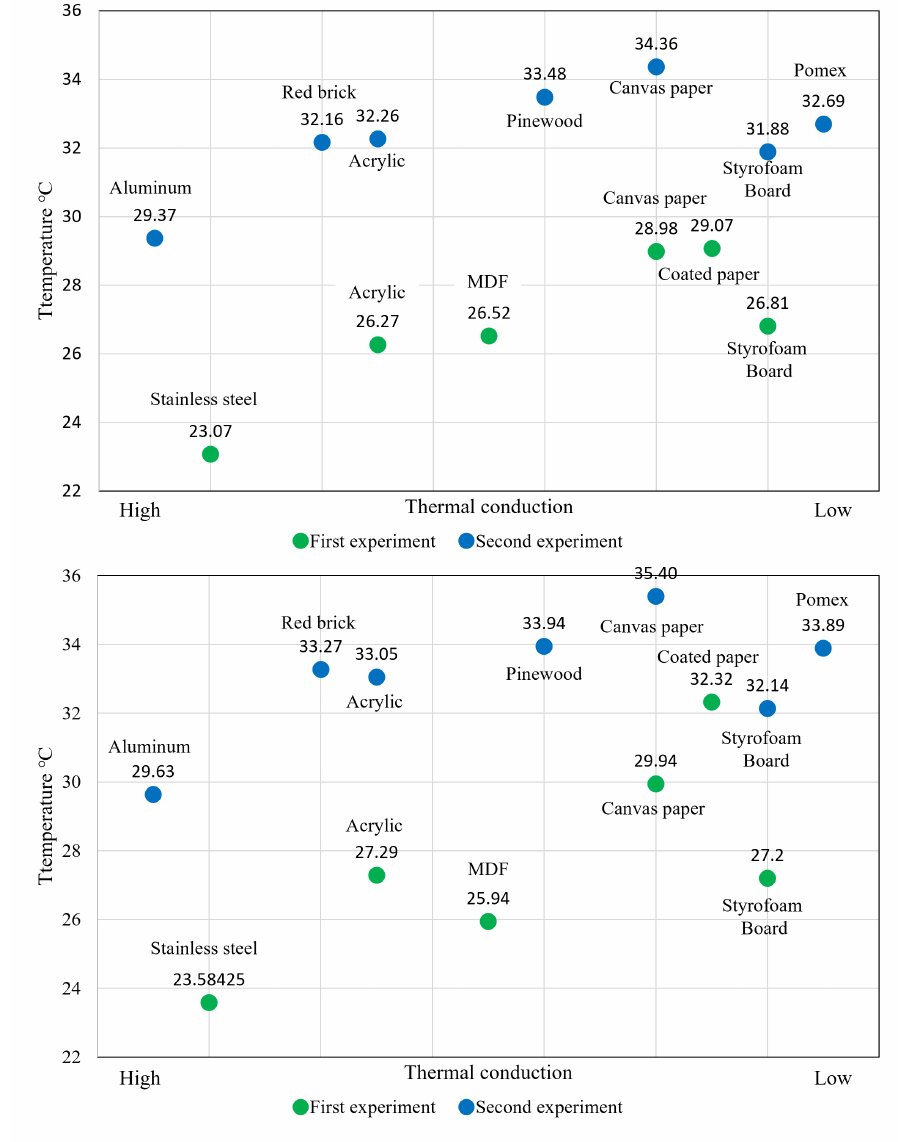
Figure 10. Distribution of conduction hot spot generation temperature according to material group 2 Top : fingertip touch, bottom : using hollow